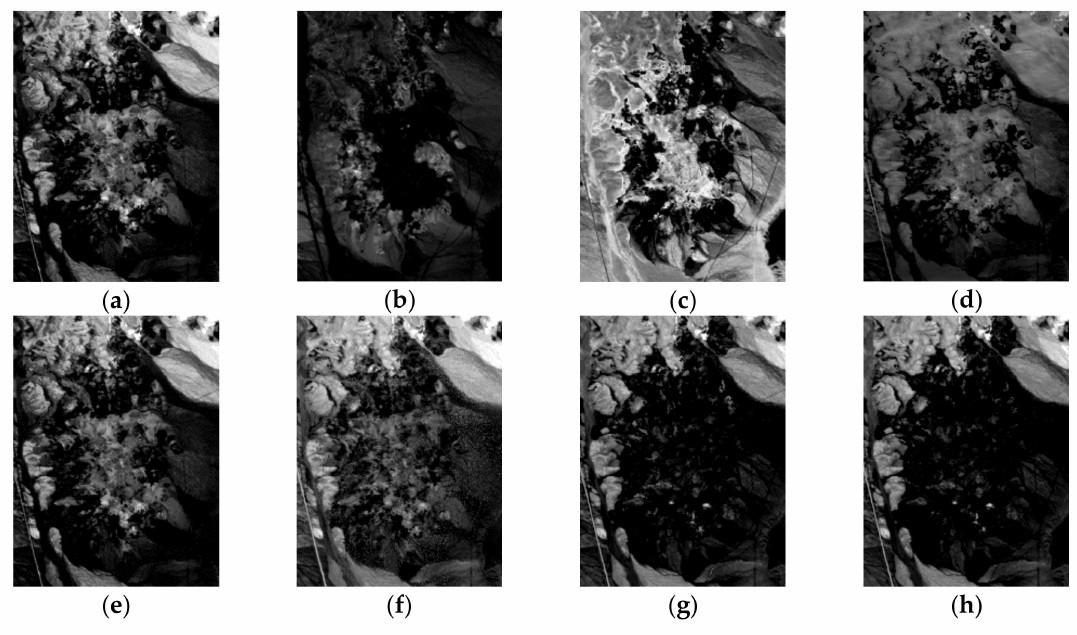
Figure 16. Desert varnish: ( a ) VCA, ( b ) N-FINDR, ( c ) SGA, ( d ) C-NMF, ( e ) MVC-NMF, ( f ) ICE, ( g ) SPICE, ( h )